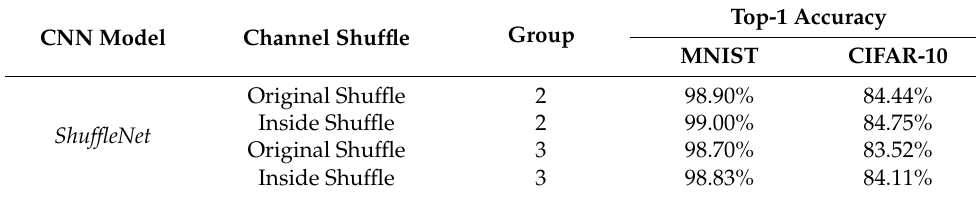
Table 2. Accuracy of experimental results.